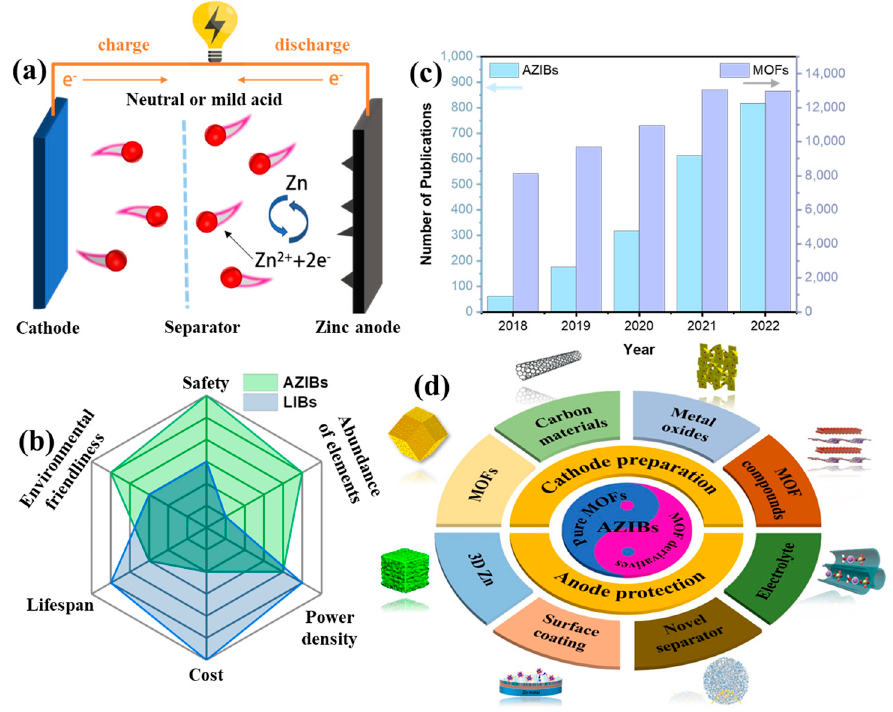
Figure 1. ( a ) Mechanism of AZIBs. ( b ) Multi-angle comparison of AZIBs and LIBs. ( c ) Total number of scientific publications on MOFs and AZIBs published in recent years (data collected form Clarivate Web of Science; keywords used: “metal-organic frameworks”, “aqueous zinc-ion batteries”). ( d ) Graphical abstract of this